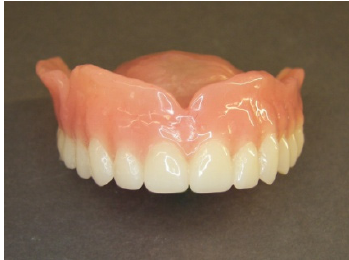
Figure 22. The digitally manufactured CD after the finishing and polishing procedures.